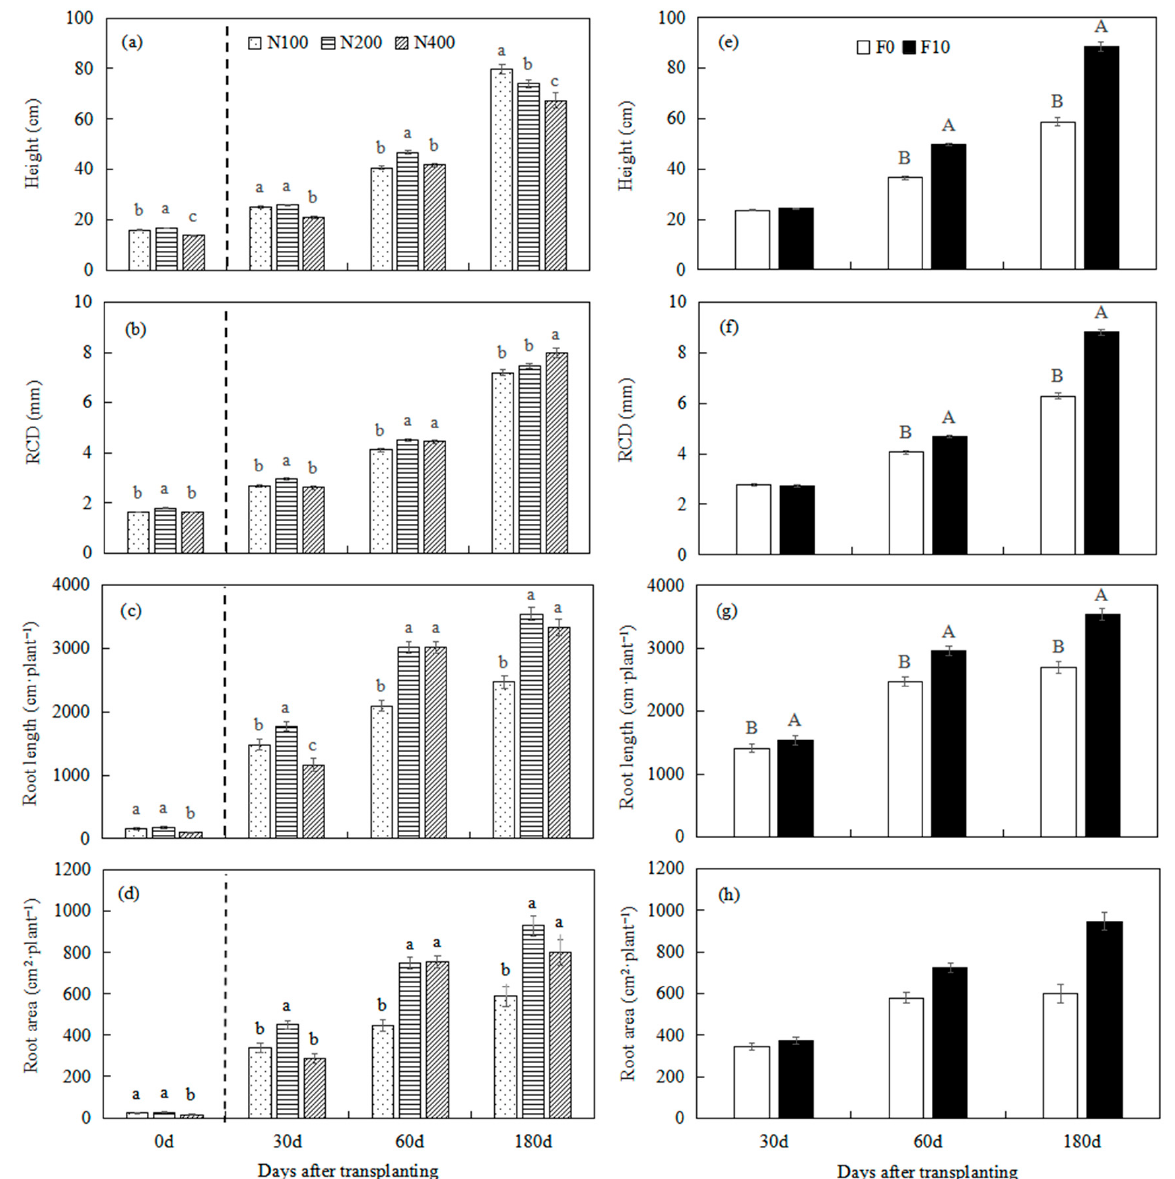
Figure 1. The main effects of nutrient loading (N) and fertilization at transplanting (F) on Betula alnoides height, root collar diameter (RCD), root length, and root area. Different lowercase (a, b, c) and uppercase (A, B) letters represent significant differences among nutrient loading and between transplant fertilization treatments, respectively, within each sampling time at p < 0.05 according to the Duncan’s multiple range test. Vertical bars are standard errors of the means ( n = 6 in ( a – d ) or n = 9 in ( e – h )). See Table 3 for ANOVA summary.